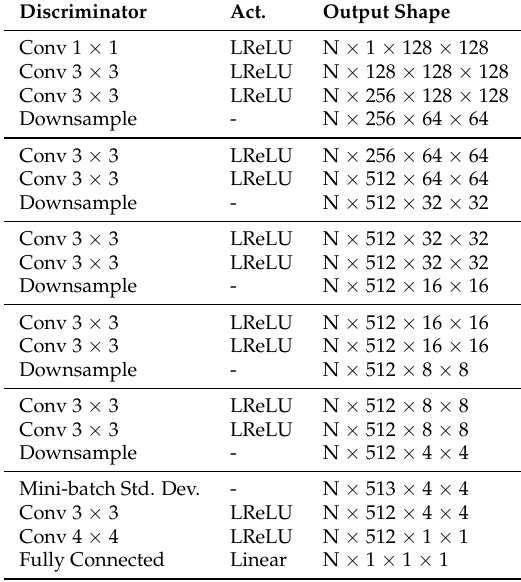
Table 2. A layer-wise overview of the discriminator network